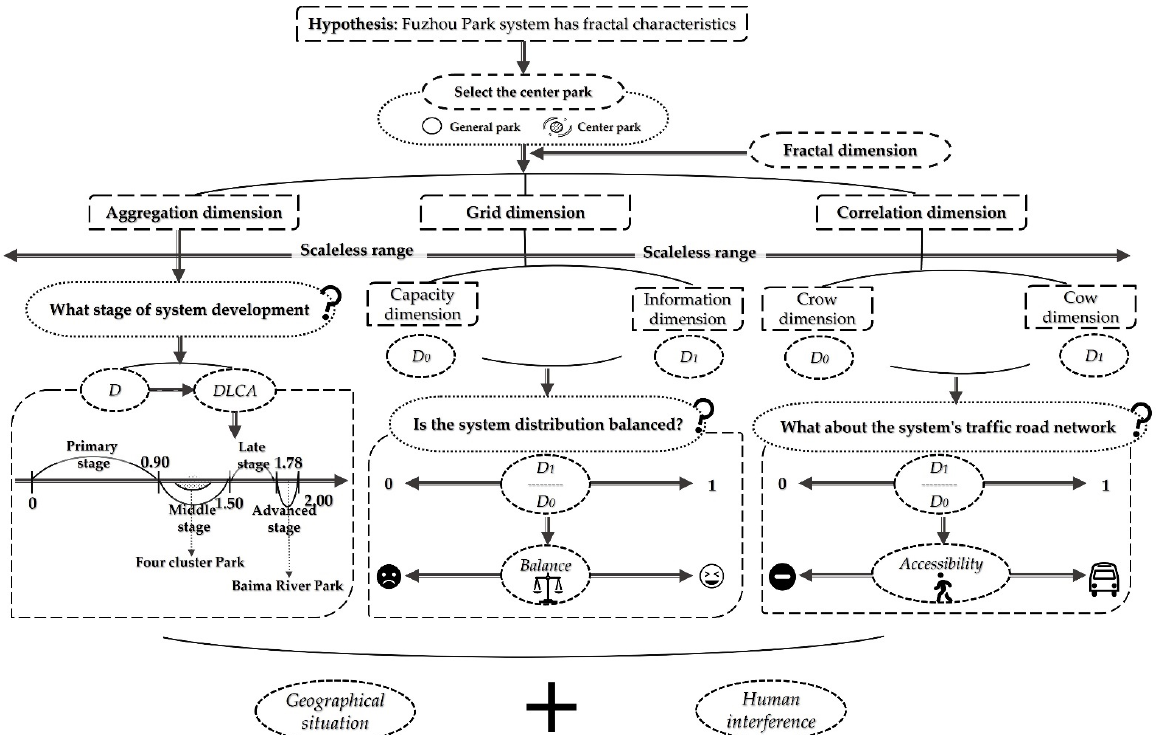
Figure 2. Framework diagram of the study. Note: Diffusion-Limited Cluster Aggregation abbreviated as DLCA.